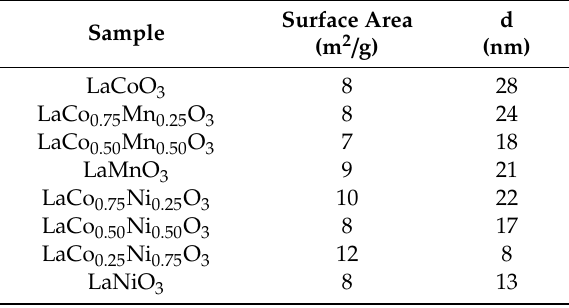
Table 1. Brunauer–Emmett–Teller (BET) surface area and crystallite size (d) calculated using the Scherrer